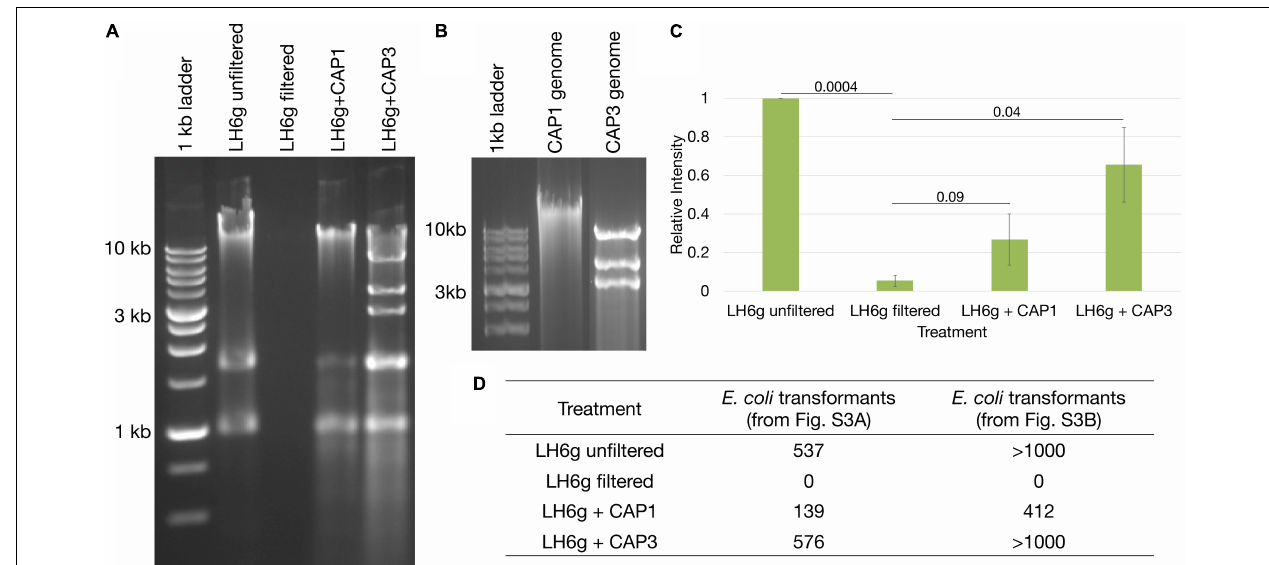
FIGURE 3 | Bacteriophage-mediated DNA release. (A) Analyses of extracellular DNA from cultures with and without phage infection. Agarose gel electrophoresis showing intact DNA release from phage-infected cultures, including cellular RNA at approximately 1 and 1.7 kb (see Supplementary Figure S2 ). (B) Agarose gel electrophoresis of CAP1 and CAP3 genomes. (C) Relative intensities of PCR products from Supplementary Figure S3 were averaged for each treatment and are represented from triplicate experiments. Standard error of the mean is represented by the error bars, and Student’s paired T -tests were performed with p -values indicated. (D) Chemically competent E. coli were transformed with equal amounts of isolated DNA from sample sets from Supplementary Figures S3A,B and the number of kanamycin resistant colonies are